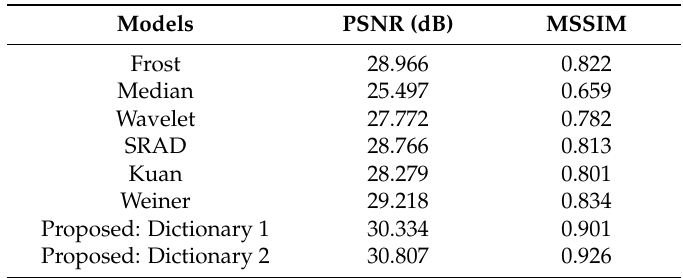
Figure 6. Reconstruction of liver right lobe images. ( a ) Original ultrasound image; ( b ) Speckled ultrasound image (PSNR = 28.148 dB); Images reconstructed using ( c ) Dictionary 1 (PSNR = 35.033 dB) and ( d ) Dictionary 2 (PSNR = 35.537 dB). Table 2. PSNR and MSSIM for the ultrasound liver image for σ = 15.